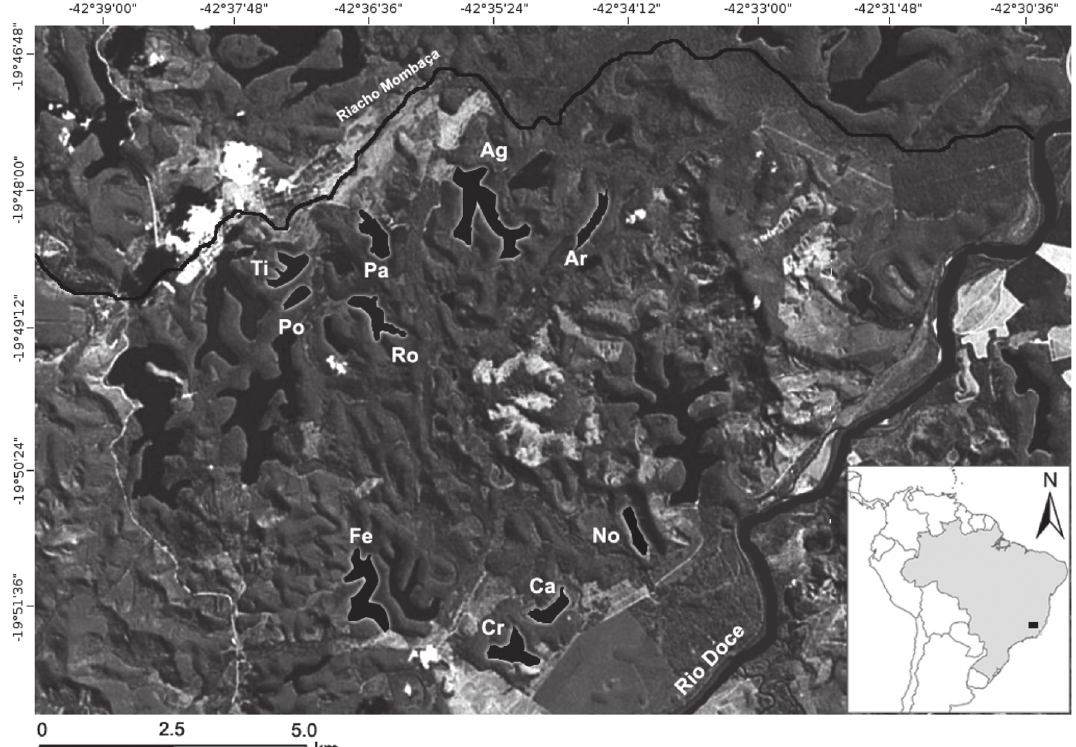
Fig. 1. Study region, indicating the ten sampled lakes. The lakes Capim (Ca), Ferrugem (Fe) and Nova (No) have only native fish species, lakes Crentes (Cr), Poço Redondo (Po), Romoalda (Ro), and Timburé (Ti) have non-piscivorous non-native fish species present, and lakes Águas Claras (Ag), Ariranha (Ar), and Palmeirinha (Pa) have non-native piscivores